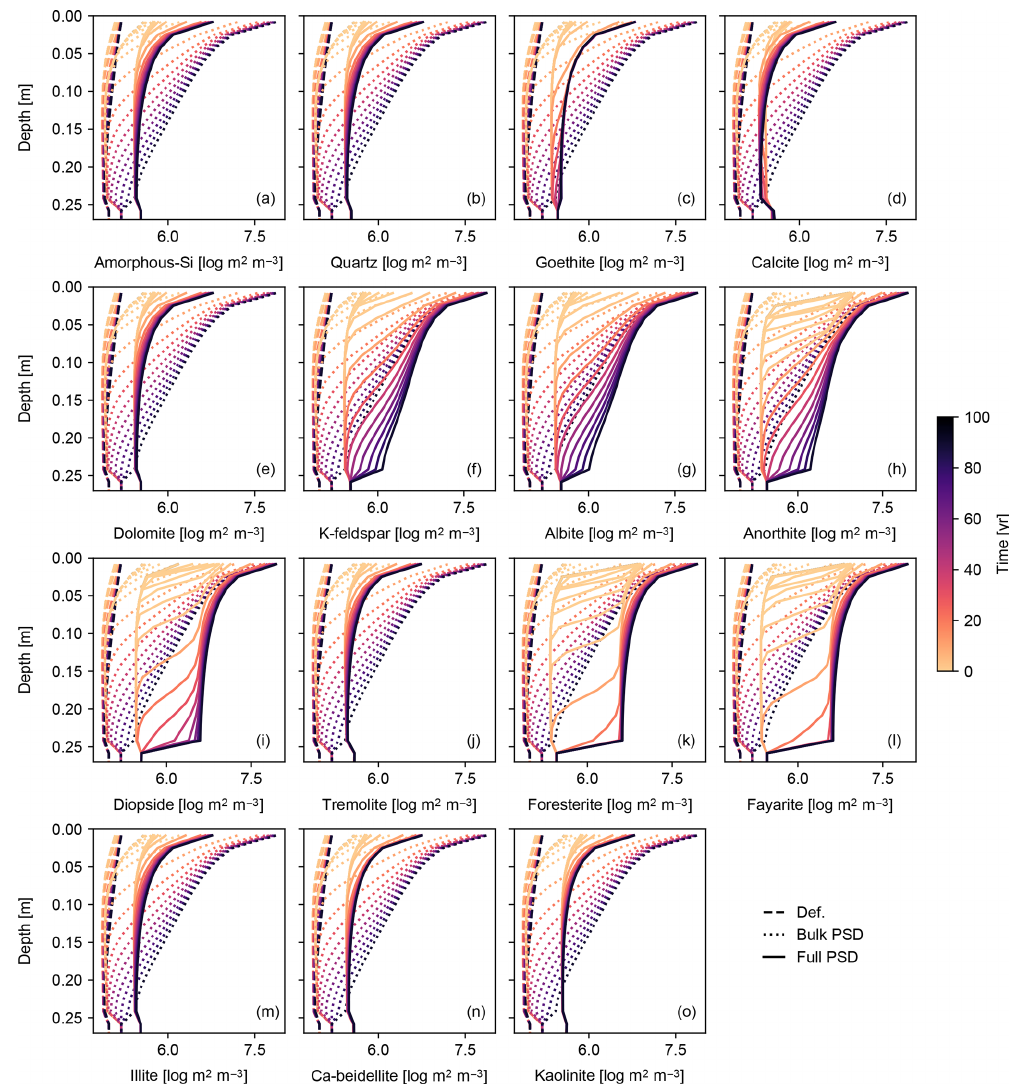
Figure 12. Surface area of individual solid species per unit pore volume plotted against depth (focused on mixed layer; 0–25cm) in simulation of basalt powder application at Site 1 in Table 8 with the surface area calculated based on tracked PSDs for individual solid species (“Full PSD”). The pore surface areas per unit pore volume calculated with the default parameterization (“Def.”) and based on PSD for bulk soil (“Bulk PSD”) are also plotted for comparison. See Sect. 3.1.4 and Table 7 for details on the boundary conditions of the